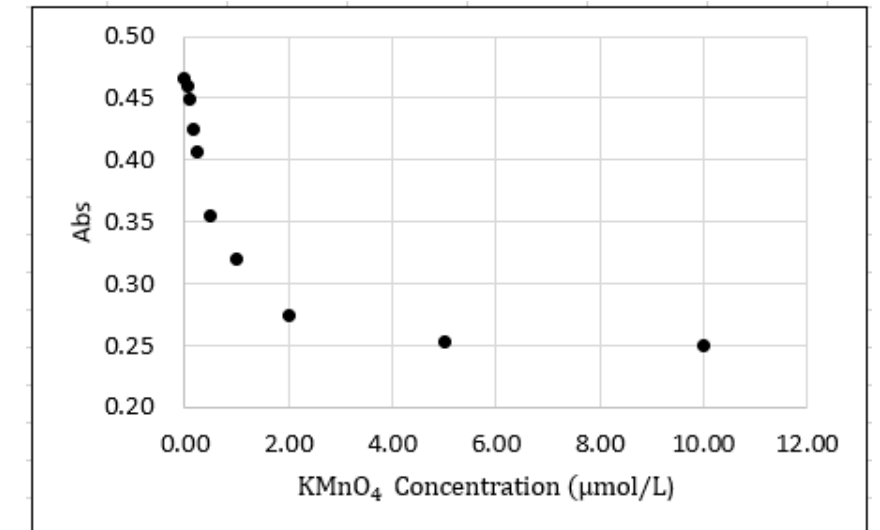
Figure 4. Absorbance as a function of KMnO 4 concentration (0.05 to 10 µM).